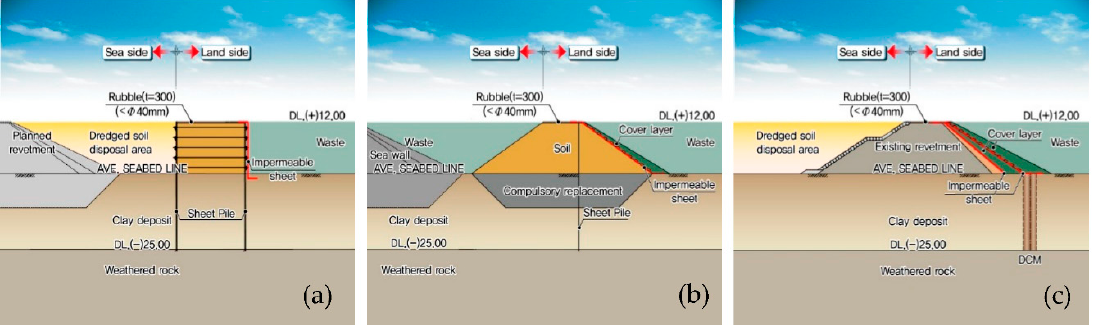
Figure 8. Cross-sections of the revetments constituting the offshore waste disposal facility that have been modified based on the subsystem hazard analysis. ( a ) The barrier revetment corresponding to Sections A–E; ( b ) the separating revetment corresponding to Section I; and ( c ) the connection revetment corresponding to Section L.